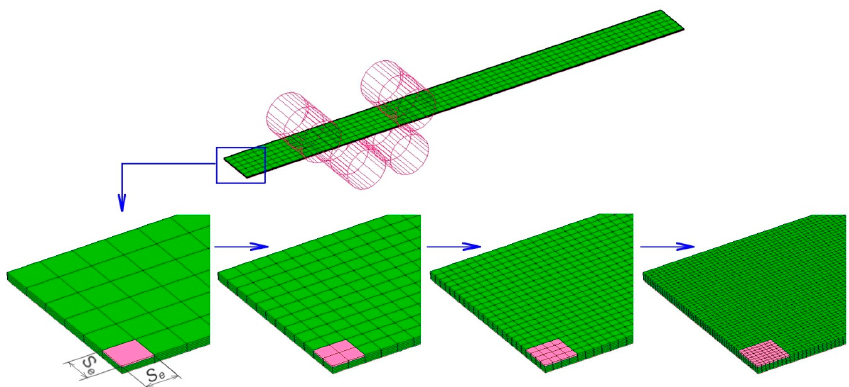
Figure 8. View of the mesh in the mesh sensitivity analysis (MSA).